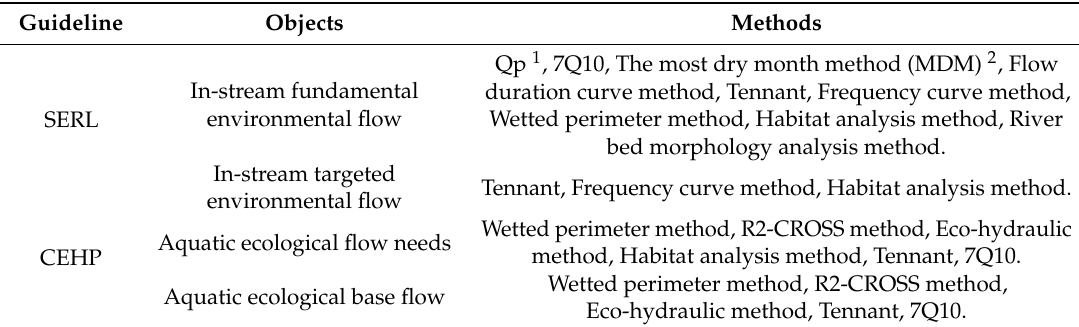
Table 5. Recommended methods of the two standards for development of water use projects.